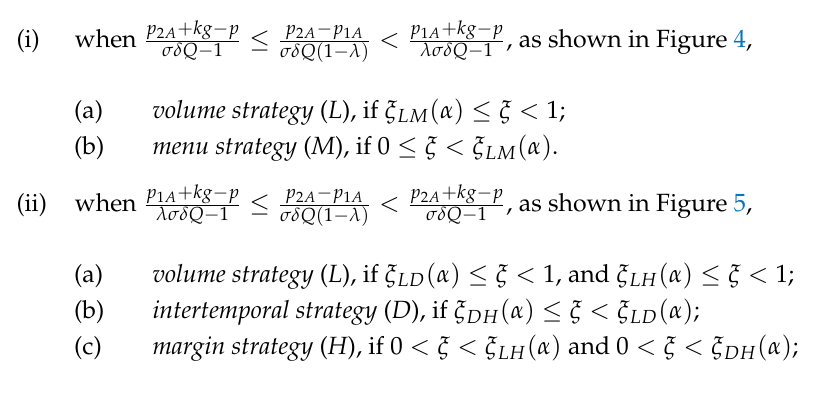
Figure 3. Comparison of the four strategies given (cid:2012) (cid:3404) (cid:2869)